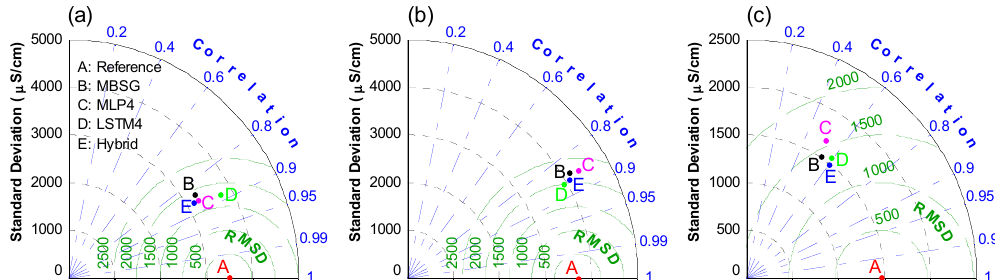
Figure 5. Taylor Diagrams displaying statistics (correlation, standard deviation, and centered root mean square di ff erence) between the reference salinity at Martinez and the corresponding salinity simulations generated via four di ff erent models (MBSG, MLP4, LSTM4, and Hybrid MBSG–CNN) grouped in three salinity ranges including ( a ) low salinity range (less than 25% non-exceedance probability), ( b ) medium salinity range (between 25% and 75% non-exceedance probability), and ( c ) high salinity range (above 75% non-exceedance probability).